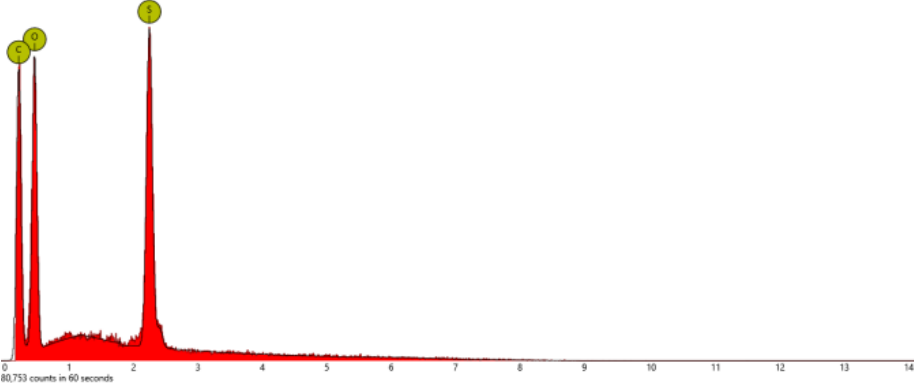
Figure 5. Energy dispersive x-ray spectroscopy ( EDS) of the PSPhSILi nanoparticles.